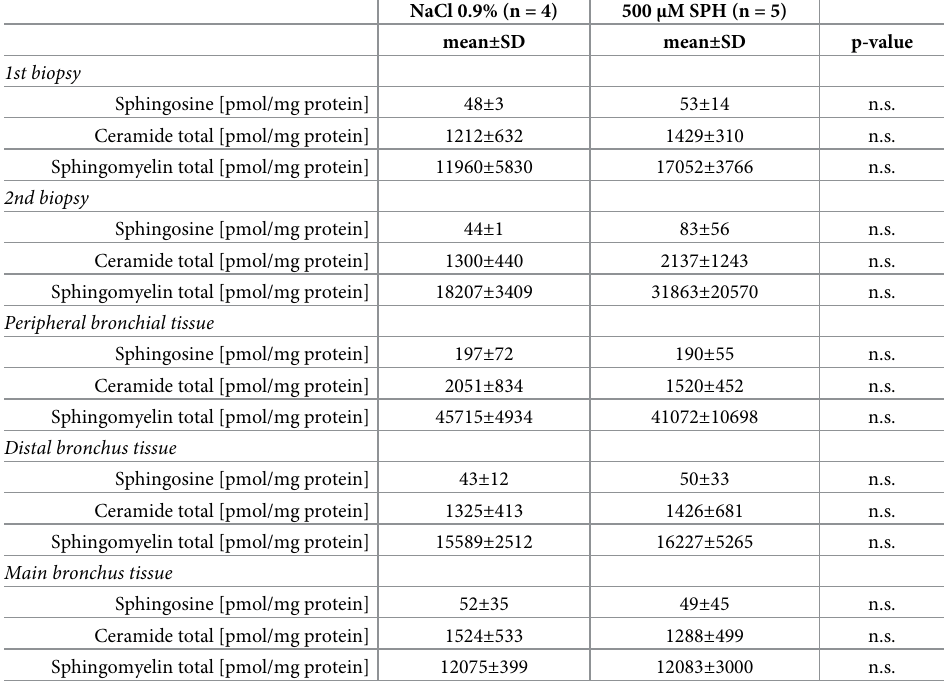
Table 1. Mass spectrometry analysis of total sphingosine, ceramide and sphingomyelin in biopsies and tissue sam- ples from EVLP pig lungs after infection and inhalation of sphingosine (500 μ M SPH) or saline (NaCl 0.9%).